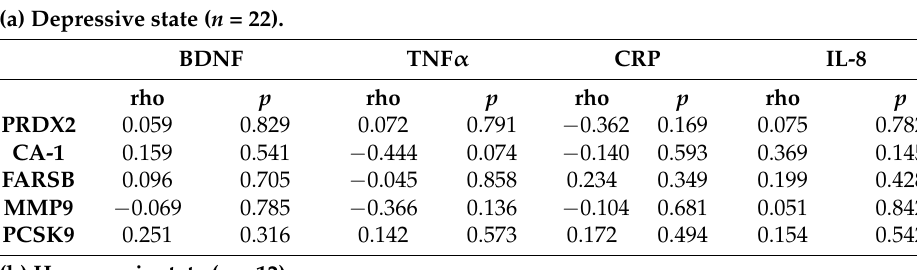
Table 4. Correlation between level of protein levels and cytokine and BDNF in BD-II divided by different mood